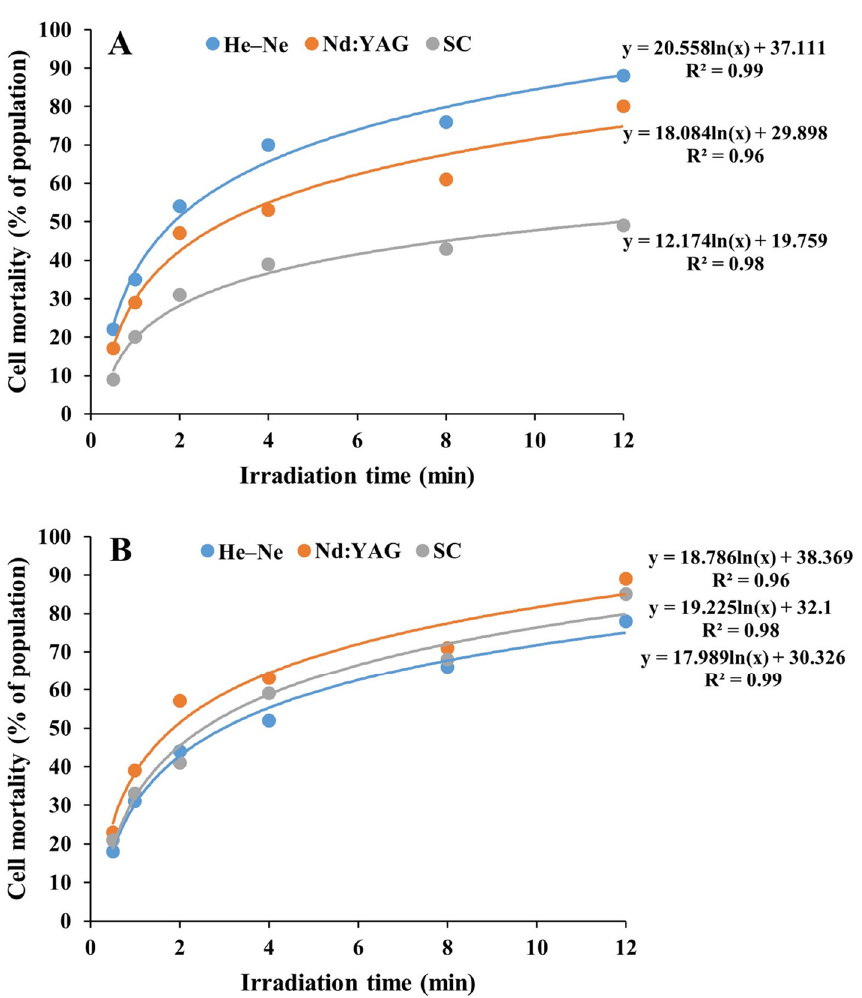
Figure 1. Figure 1. Cell mortality of laser mutants derived from Chlorella vulgaris strain FACHB 9 ( A ) and C. pyrenoidesa strain FACHB 31 ( B ) treated with three types of laser irradiation under different lengths of treatment